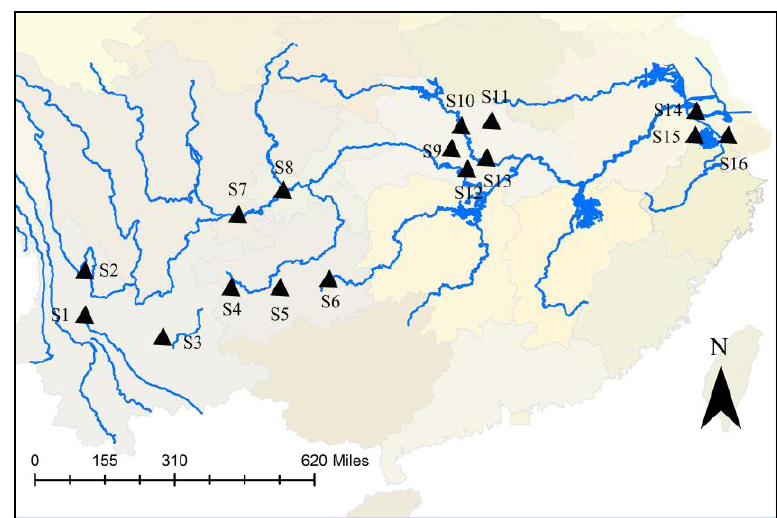
Figure 5. Yangtze River sampling sites in this study.